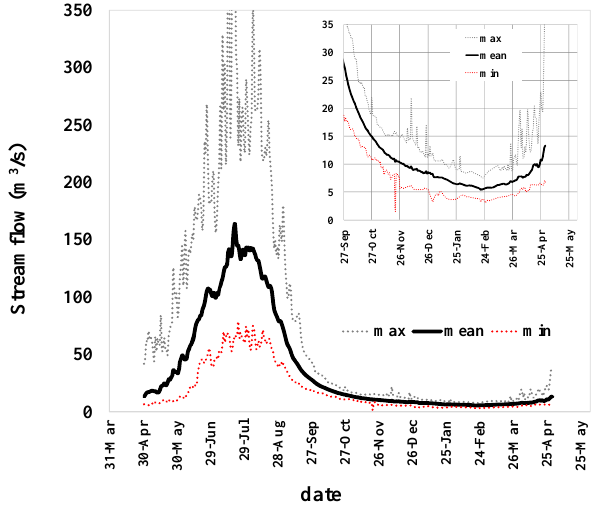
Fig. 3 The measured mean streamflow process of Manas River, Tianshan, Northwest China (max, 2 Fig. 3. The measured mean streamflow process of the Manas River, Tianshan, Northwest China (max=the maximum daily flow rate; the maximum daily flow rate; min, the minimum daily flow rate; mean, the mean daily flow rate 3 min=the minimum daily flow rate; mean=the mean daily flow rate from 1961 to 1999).